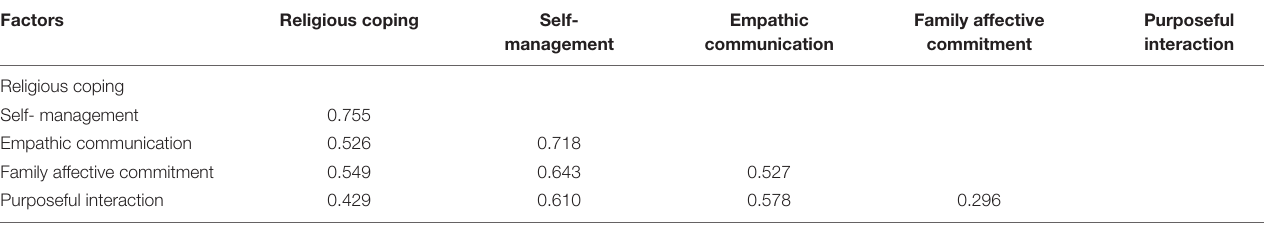
TABLE 5 | The results of HTMT of FCHS.